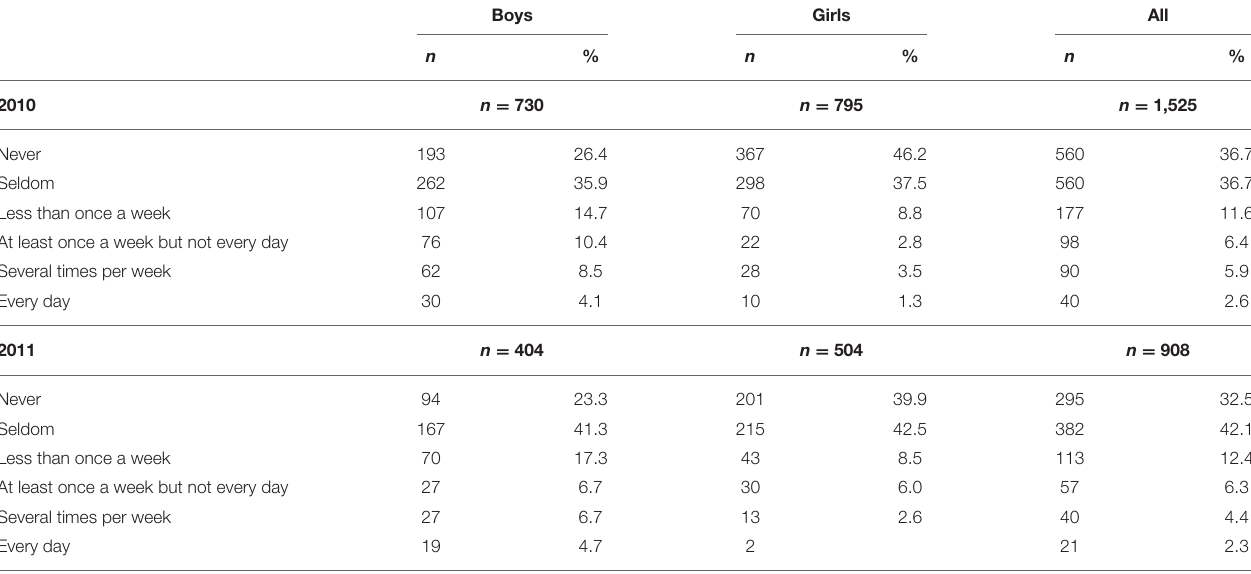
TABLE 2 | Consumption of energy drinks among Swedish boys and girls in grades 6–9 in 2010 and 2011 (only those participating in 2010).